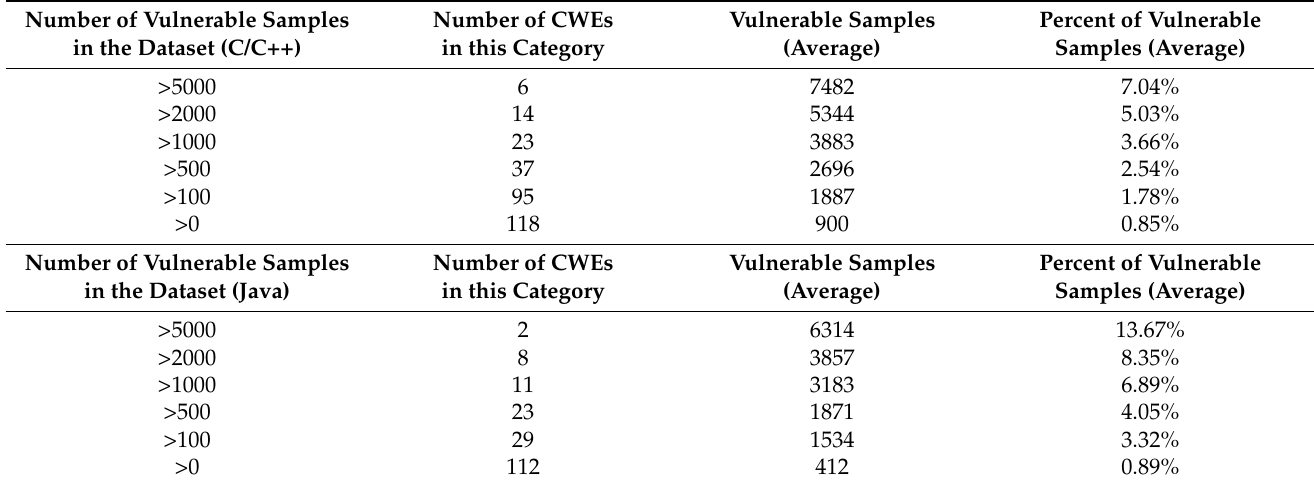
Table 2. Distribution of CWE vulnerable samples in the dataset (C/C++ and